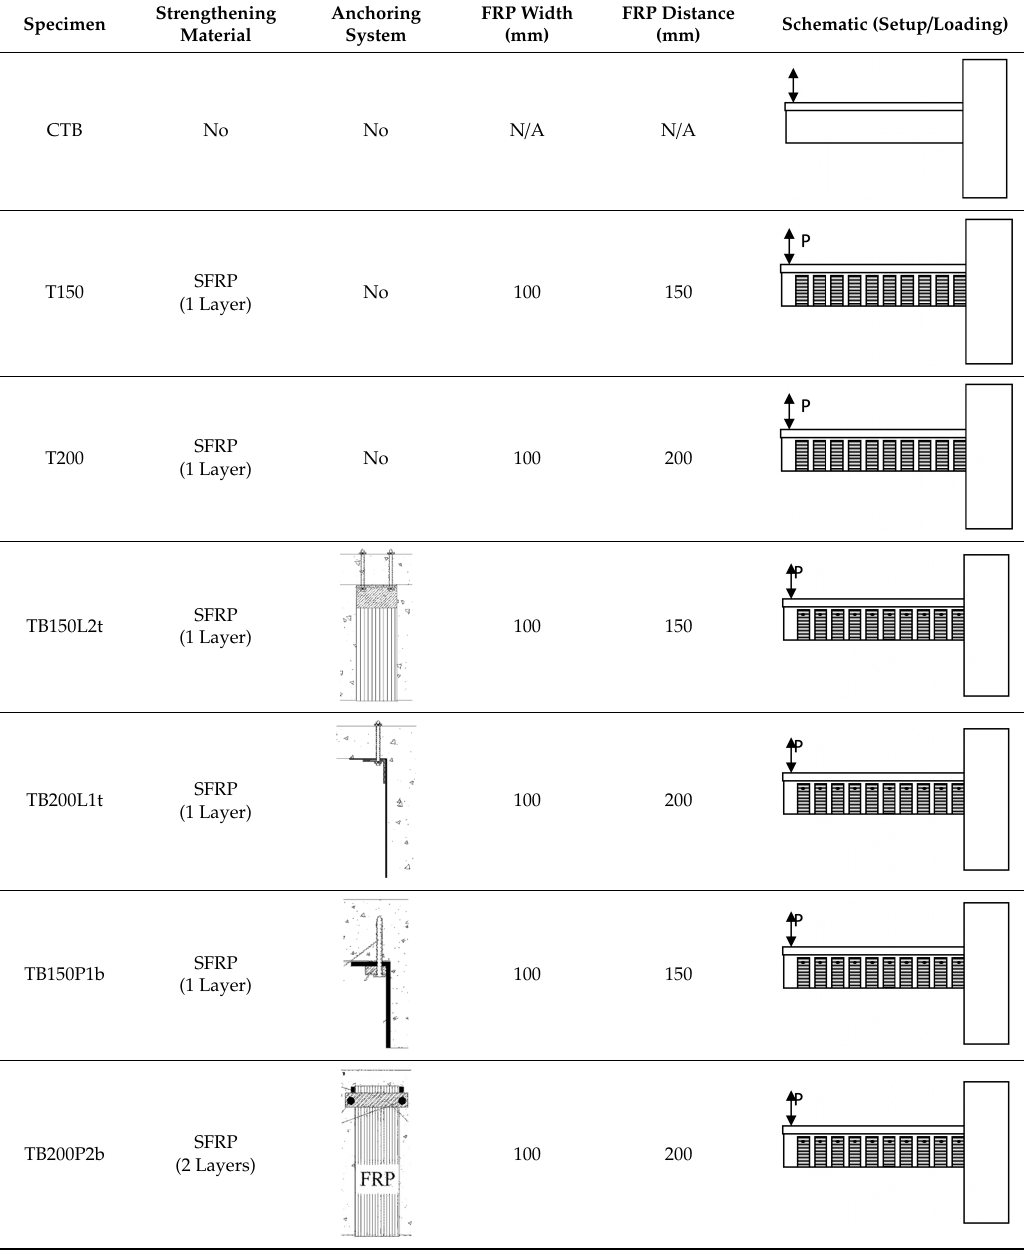
Table 1. Specimen